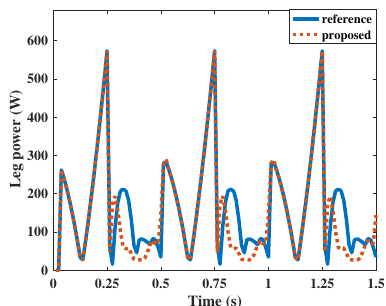
Figure 11. Leg powers of the RF leg in MATLAB.